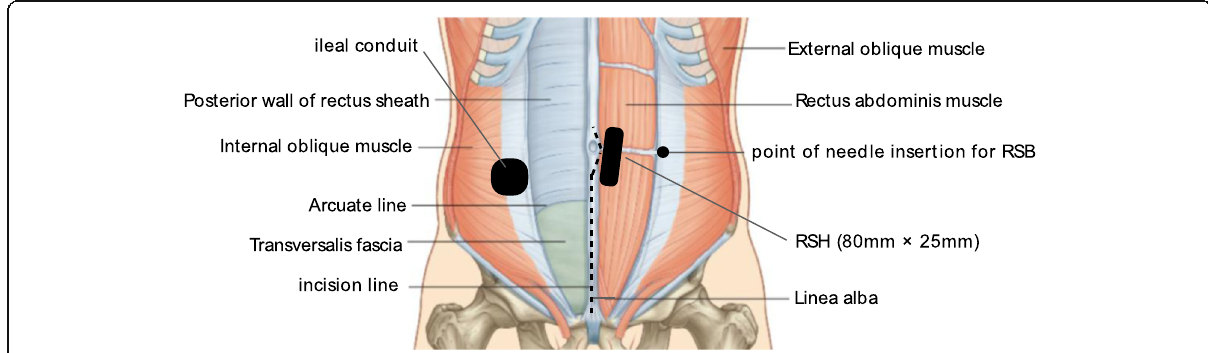
Fig. 2 Schema of the perioperative abdominal wall and site of the incision line, ileal conduit, RSH, and RSB in this case. The figure shows the site of the incision line, ileal conduit, RSH, and point of needle insertion for